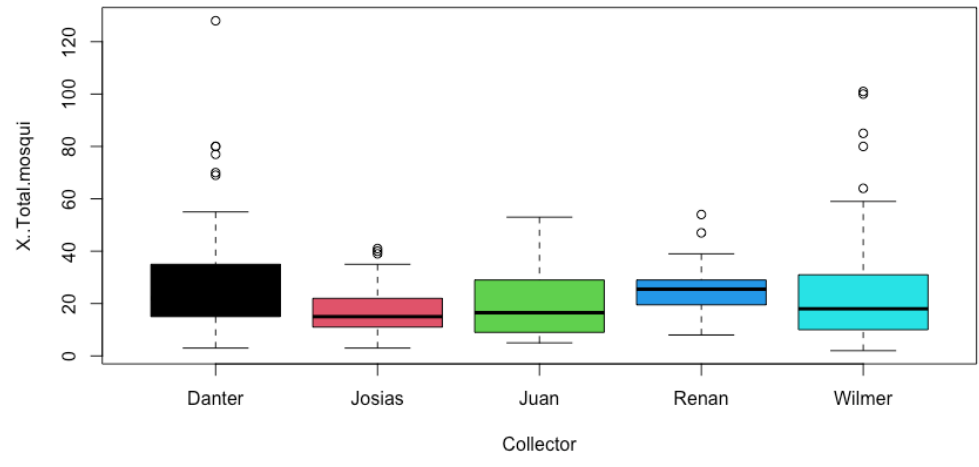
Figure A2. Mosquito captures per collector. Table A3. Basic Statistics by Collector.